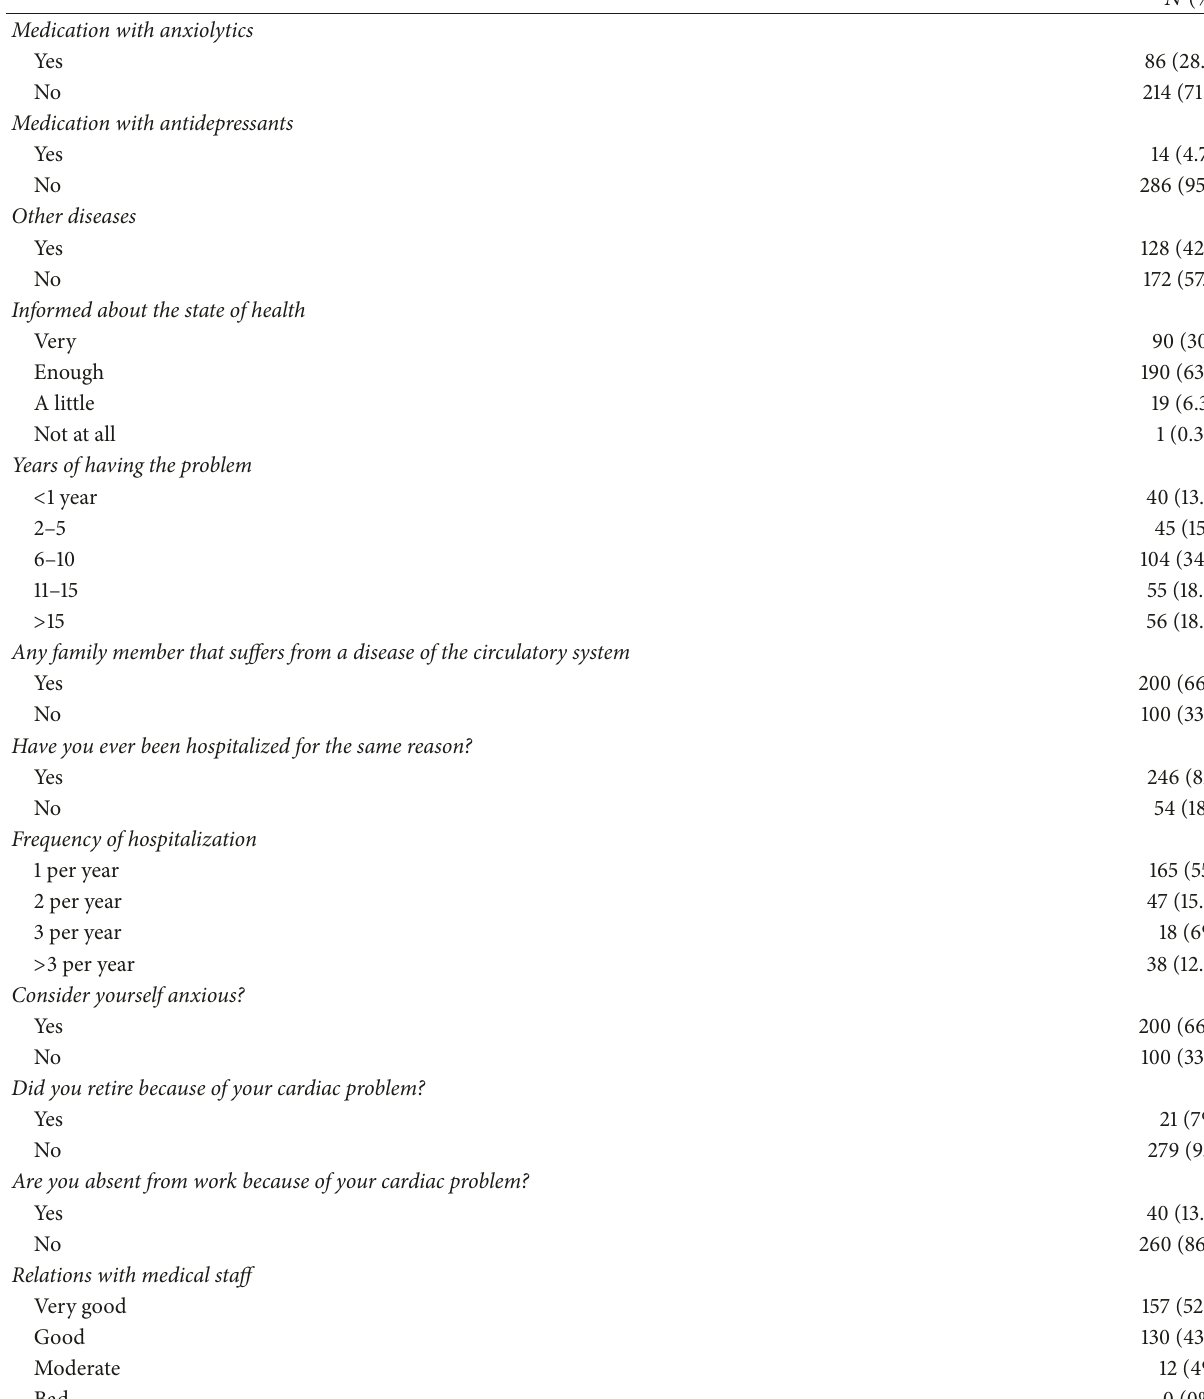
Table 2: Characteristics concerning the state of health of